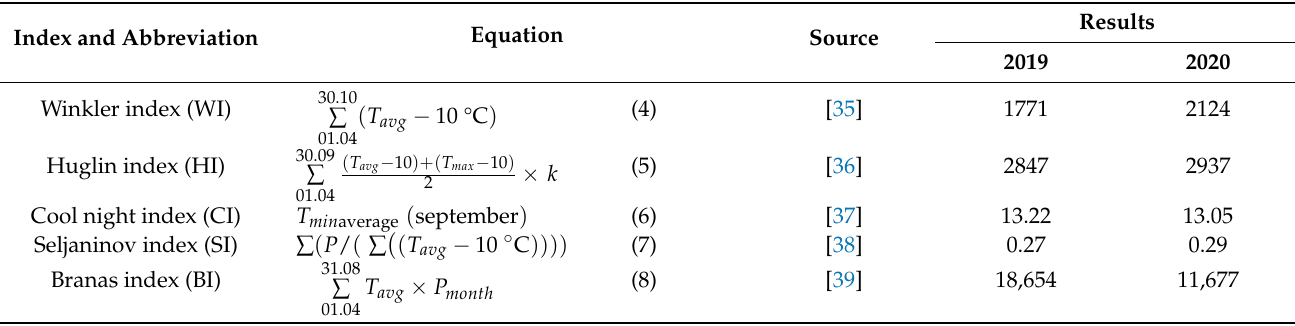
Table 1. List of the bioclimatic indices used for this study for both years, their corresponding mathematical definitions, and